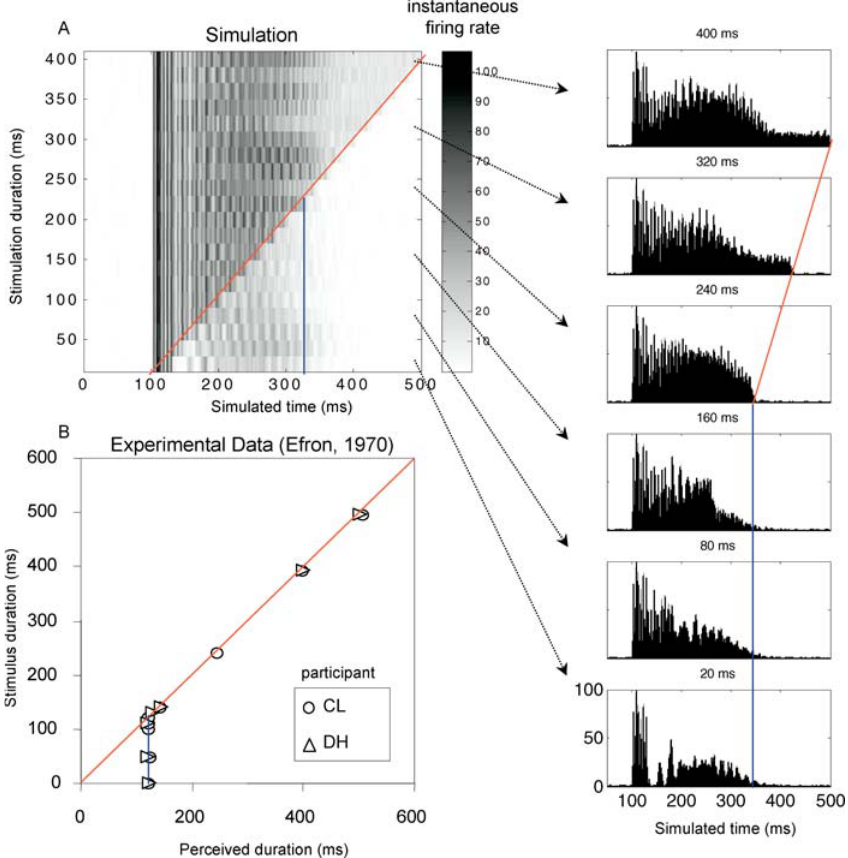
Figure 7. Duration of the Ignited State and Relation to ‘‘ Visual Persistence ’’ (A) Network response to stimuli of increasing duration (format as in Figure 5; I neuromodul = (cid:1) 0.9 l A/cm 2 ). Note how the duration of the ignition is initially constant and independent of the stimulus, then becomes proportional to it. (B) Empirical data on estimation of the subjective duration of a visual stimulus (replotted from data in Efron [44]). Both participants judged accurately the duration of stimuli above a critical duration, but judged duration to be constant below this value. DOI: